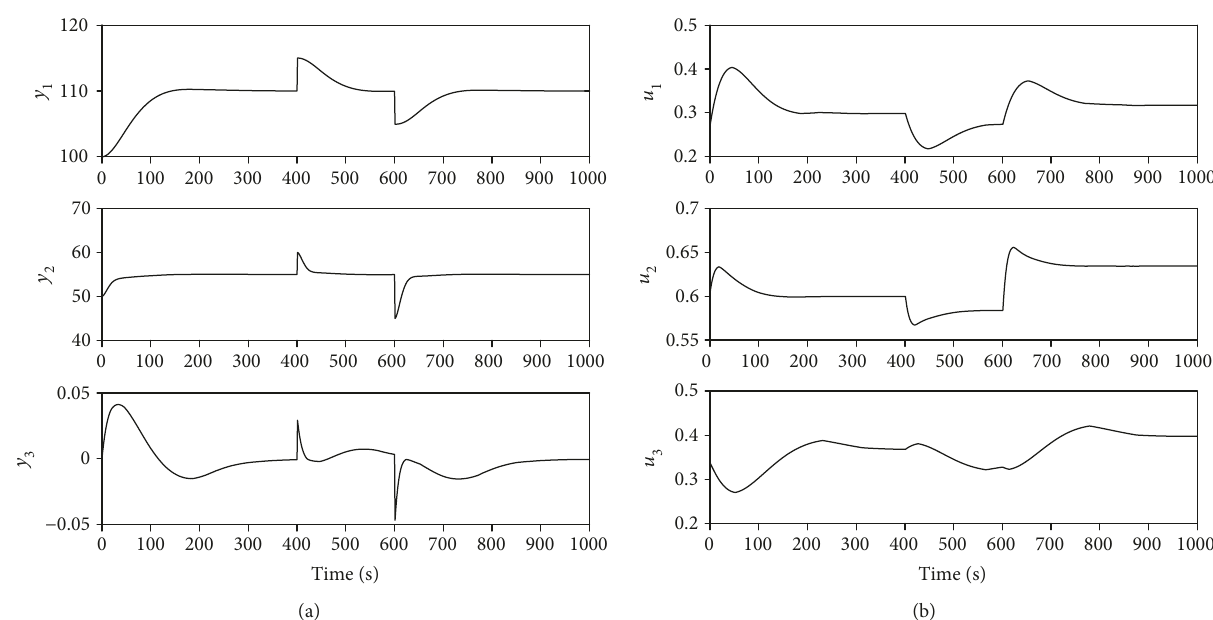
Figure 10: Outputs and controls of the unit in the case of existing constant output disturbances.